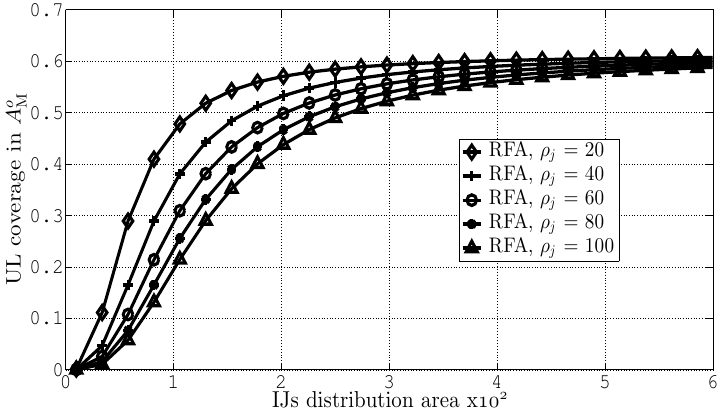
Figure 5. UL coverage against radius for IJs distribution area, with